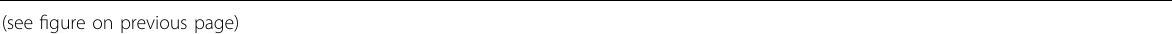
Fig. 6 CircPSMA1 promotes TNBC cell proliferation and migration through the circPSMA1/miR-637/Akt1 axis in vitro. A – D The cell proliferation of TNBC cells after cotransfecting the indicated vectors with miR-637 mimic or miR-637 inhibitor was detected by EdU assays (magni fi cation, ×100, scale bar, 100 μ m). E – G The migration abilities of TNBC cells after cotransfecting the indicated vectors with miR-637 mimic or miR-637 inhibitor were detected by transwell assays (magni fi cation, ×100, Scale bar, 100 μ m). H STRING database (https://string-db.org/) was used to con fi rm the relationship of β -catenin (CTNNB1) and cyclin D1 (CCND1) with Akt1. I – K The relative expressions of Akt1, β -catenin and cyclin D1 after cotransfecting the indicated vectors with miR-637 mimic or miR-637 inhibitor were determined by western blot. L , M Relative protein levels of Akt1 after cotransfecting the indicated vectors with miR-637 mimic or miR-637 inhibitor in TNBC cells were assessed by immuno fl uorescence (IF) (magni fi cation, ×100, Scale bar, 50 μ m). Data were shown as mean ± SD, * p < 0.05, ** p < 0.01, *** p <